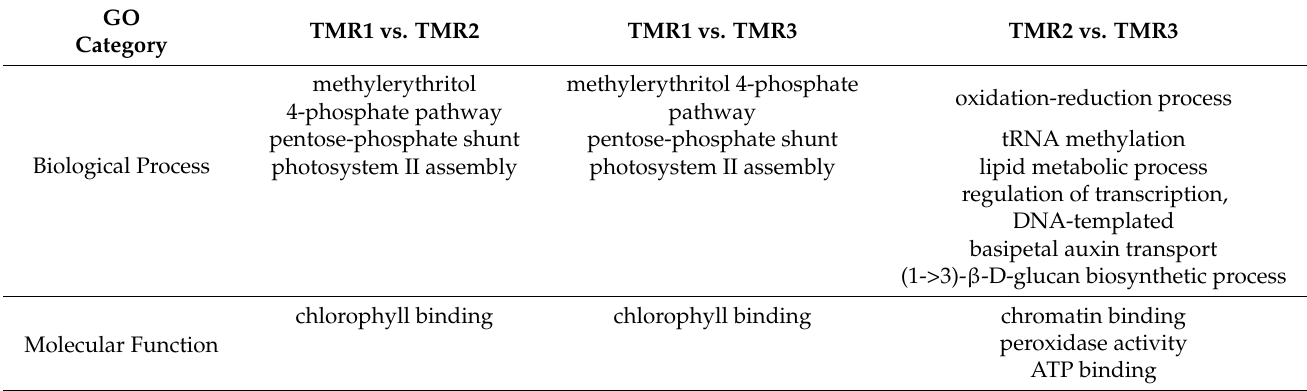
Table 2. Significantly enriched GO terms of the DEGs generated from different pair-wise comparisons.